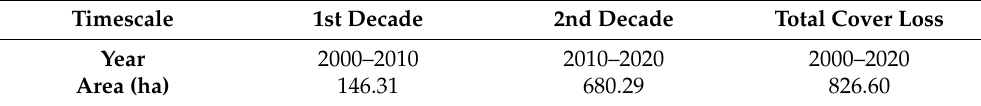
Table 5. Summary of forest cover loss estimate from Hansen Global Forest Change.